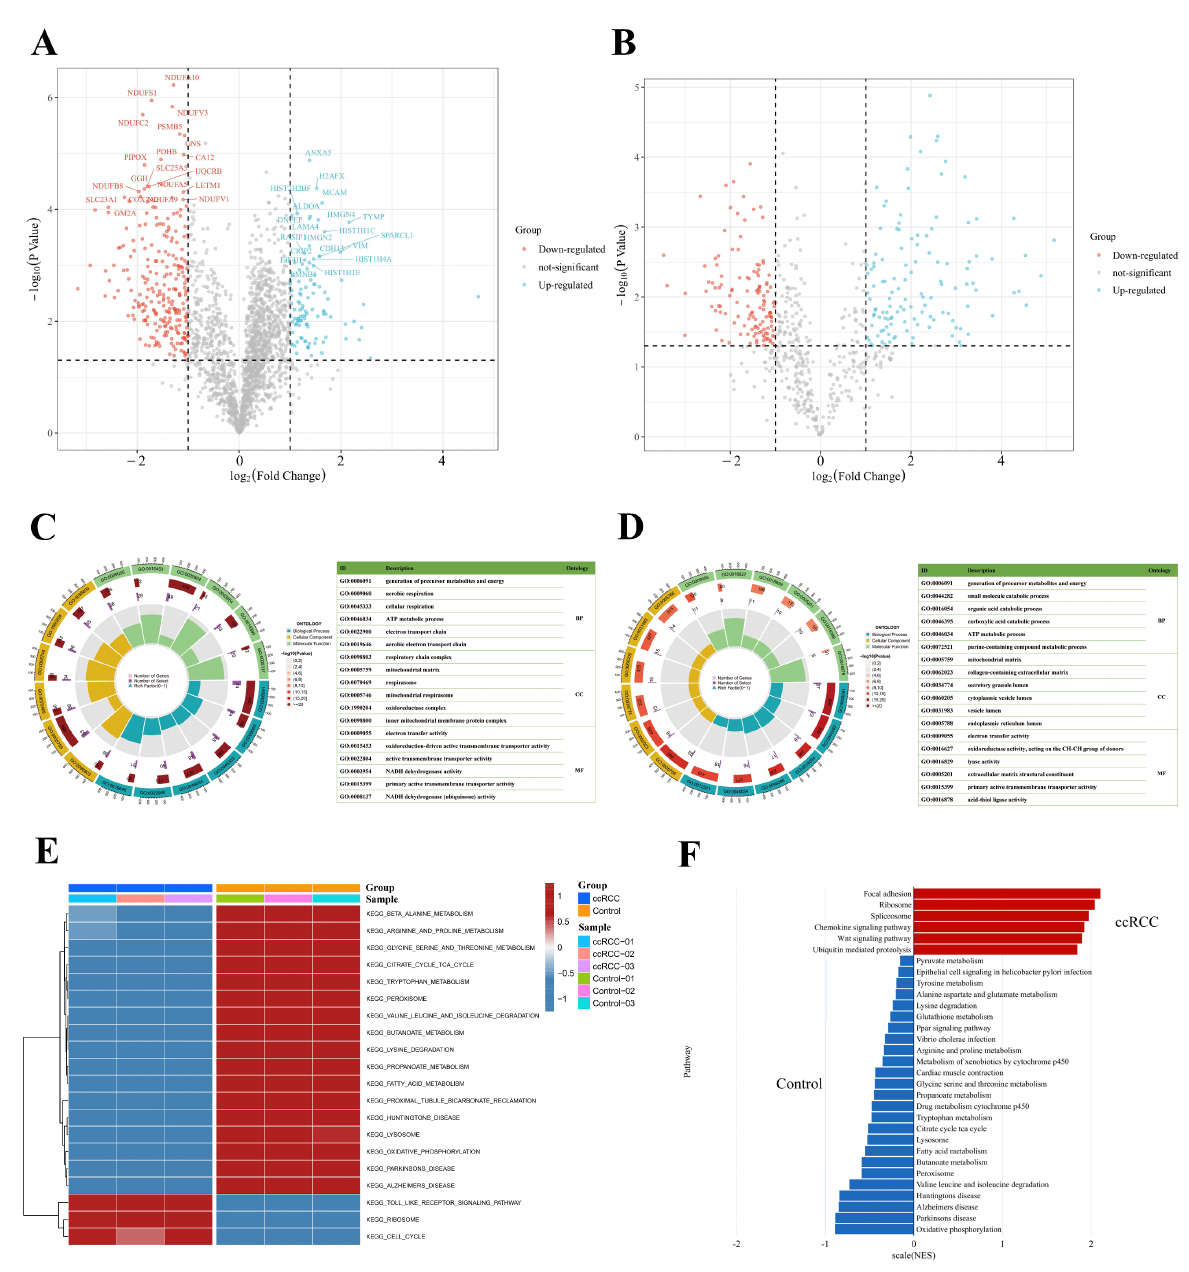
Figure 5. Integrated enrichment analysis of differentially expressed proteins and SNO proteins. ( A ) Heatmap of differentially expressed proteins; ( B ) heatmap of differentially expressed SNO peptides; ( C ) GO analysis of differentially expressed proteins; ( D ) GO analysis of differentially expressed SNO proteins; ( E ) GSVA analysis of differentially expressed proteins; ( F ) GSEA analysis of differentially expressed